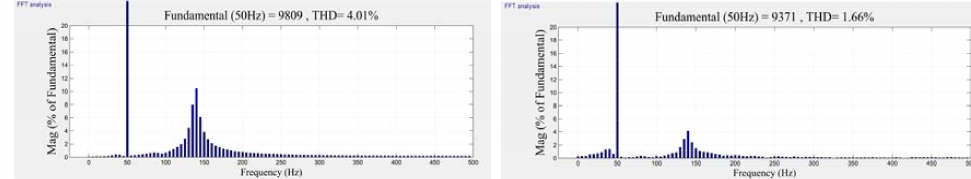
Figure 18. Case 6-FFT analysis of grid voltage and load voltage in case of fluctuations and distortions of